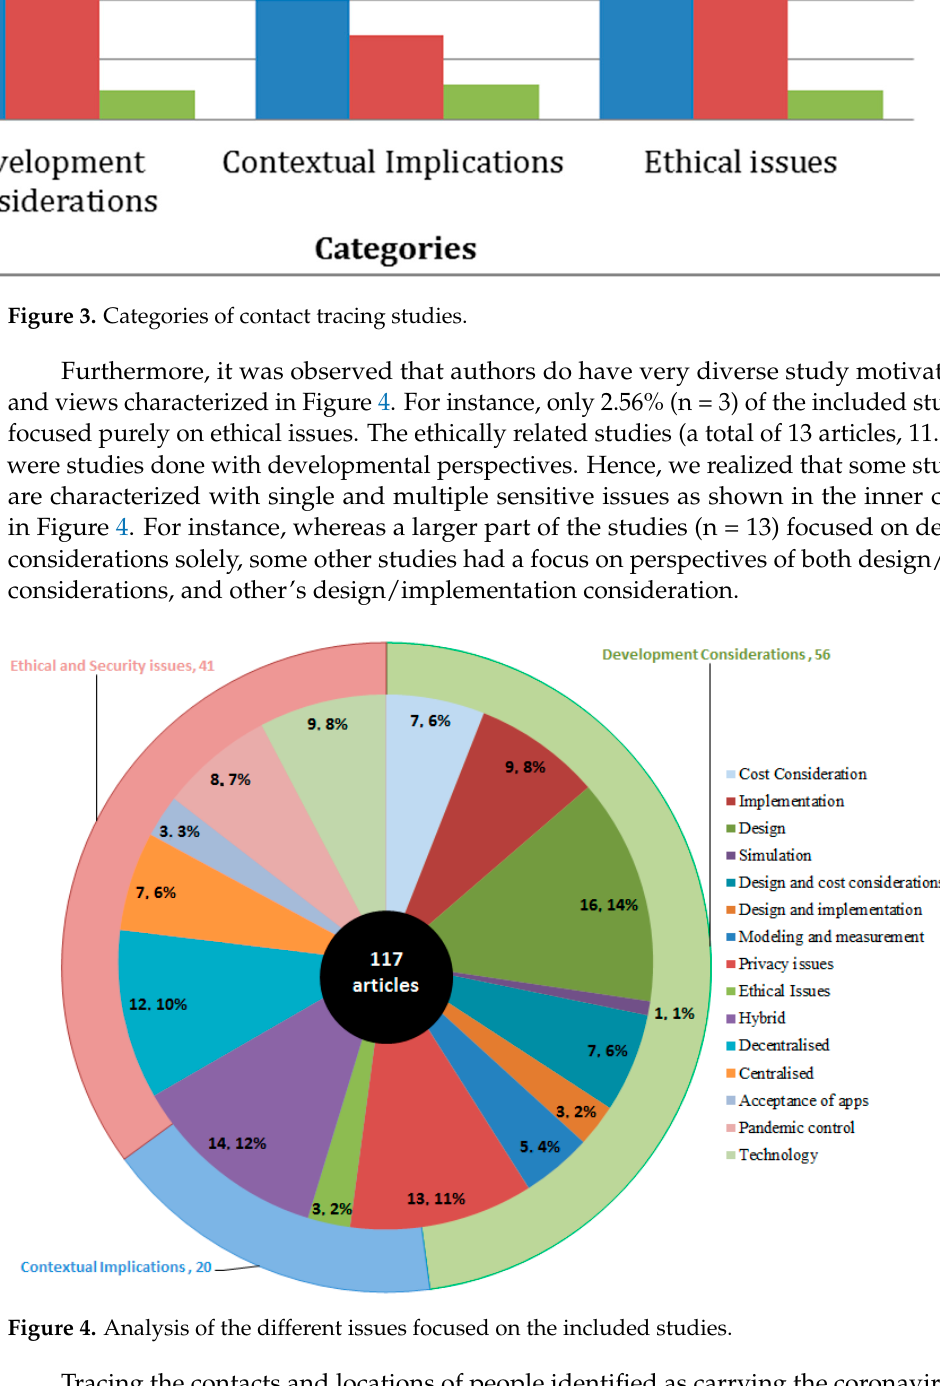
Figure 2. List of countries that contact tracing studies were reported for COVID-19.